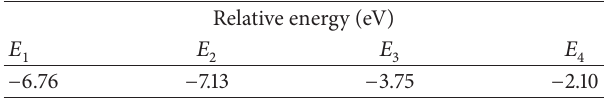
Table 2: Calculated formation energies of various pyridine-type defective graphenes.